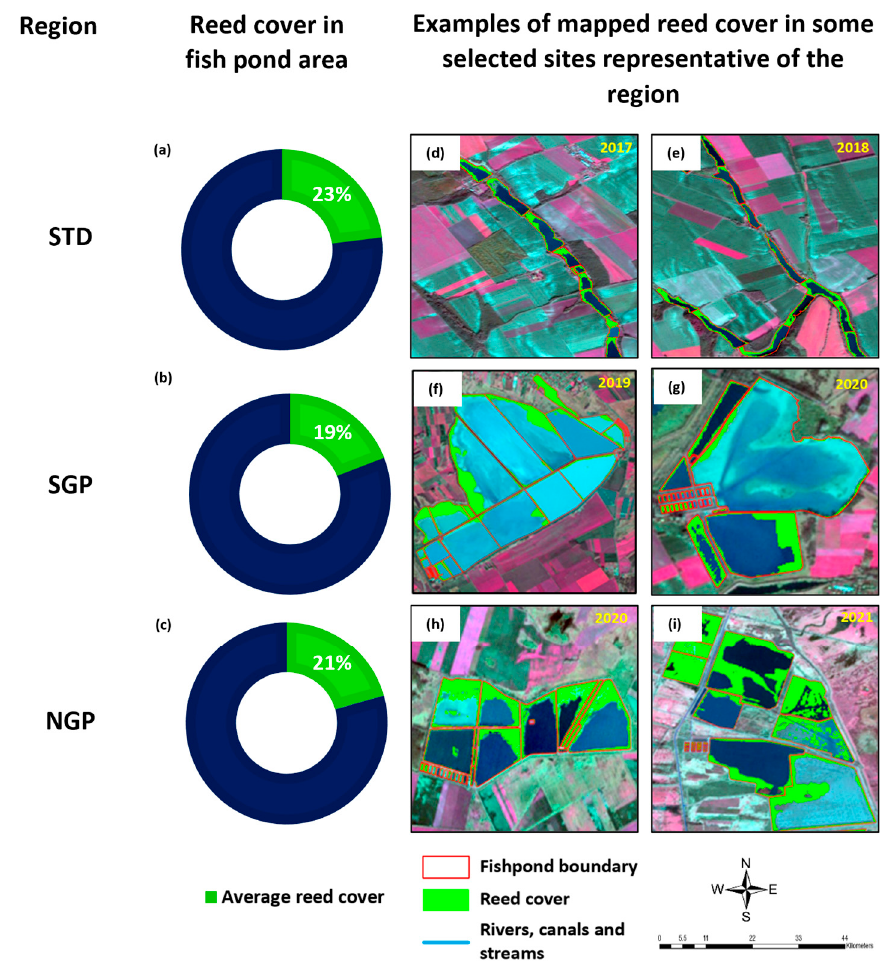
Figure 6. ( a – c ) The average area of mapped reed cover in the fish ponds in the three regions studied. Examples of mapped reed cover within the fish ponds: ( d ) the reed cover in fish ponds typical for STD in the year 2017 and ( e ) in 2018; ( f ) the reed cover in fish ponds typical for the SGP in the year 2019 and ( g ) in the year 2020; and ( h ) the reed cover in ponds typical for the NGP in the year 2020 and ( i ) in the year 2021. The Sentinel-2 false-color composite image (B11, B8, B2) was used as a basis for ( d – i ).